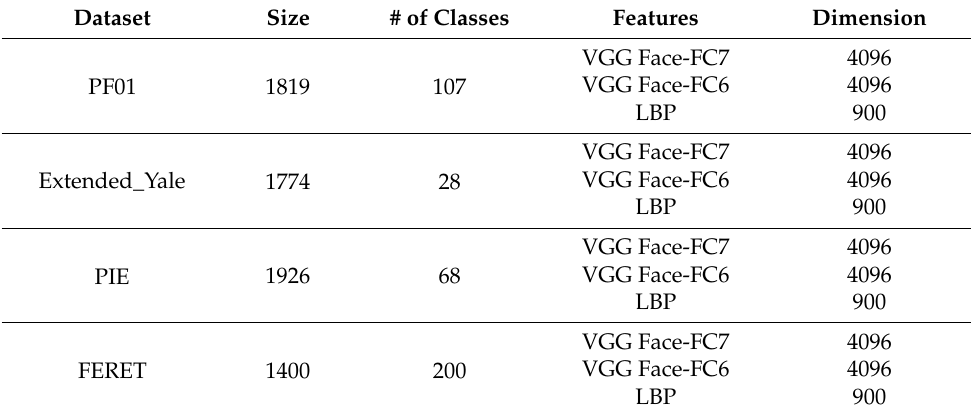
Table 2. Statistics of datasets used in experiments.